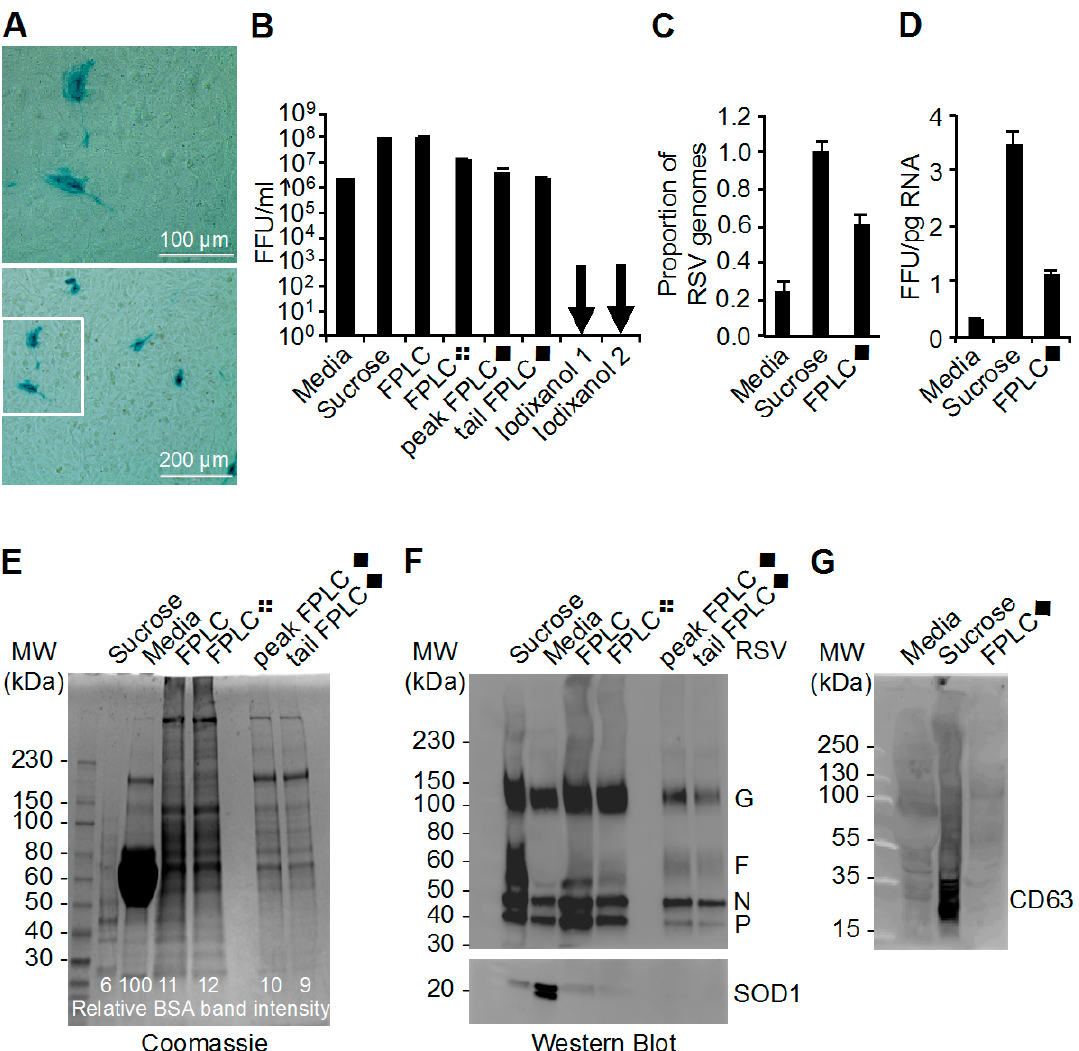
Figure 2. Infectivity and constituents of RSV stocks. ( A ) RSV was titrated on HeLa cells, fixed, and stained for RSV protein 20 h later. RSV infection was detected with a polyclonal anti-RSV antibody followed by a secondary antibody conjugated to β -galactosidase. The insoluble blue color is a product of X-Gal substrate cleavage by β -galactosidase and indicates RSV infection; ( B ) RSV focus-forming units (FFU blue spots) were manually counted and the titre of each virus preparation (outlined in Figure 1A) in FFU/mL is shown; ( C , D ) Viral RNA was extracted from RSV stock preparations and then measured by qRT-PCR; ( C ) Equivalent amounts of total RNA for each RSV preparation were probed and amplified. The proportion RSV genome detected is represented and compared to sucrose-purified RSV; ( D ) Viral titres for each of the RSV purification preparations were known and represented as FFU per picogram of total RNA; ( E , F ) RSV particles were harvested from HeLa cells in conditioned media and PEG-6000 precipitated for further purification as outlined in Figure 1A; ( E ) Coomassie blue staining of RSV stock preparations. The relative bovine serum albumin (BSA) band intensity was measured by densitometry of the 65 kDa band; ( F ) RSV proteins and superoxide dismutase 1 (SOD1) were detected by Western blot; ( G ) CD63 was detected by Western blot as an exosomal protein marker. MW: molecular weight.